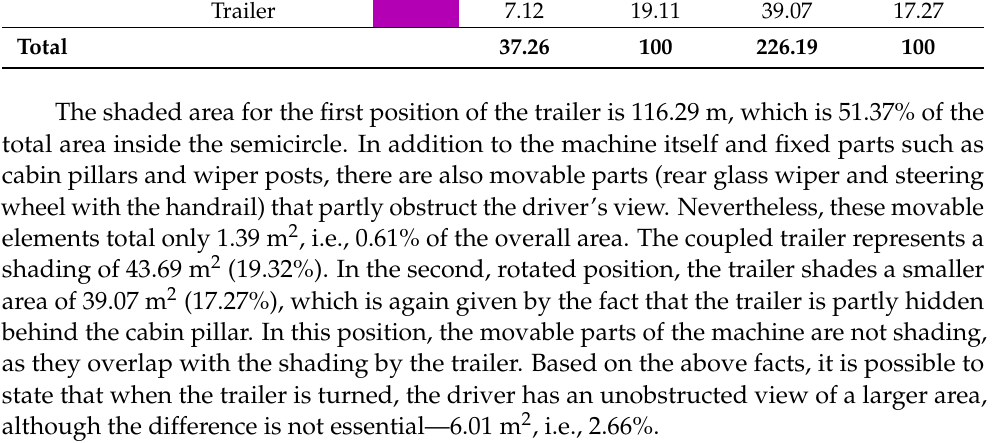
The shaded area for the first position of the trailer is 116.29 m, which is 51.37% of